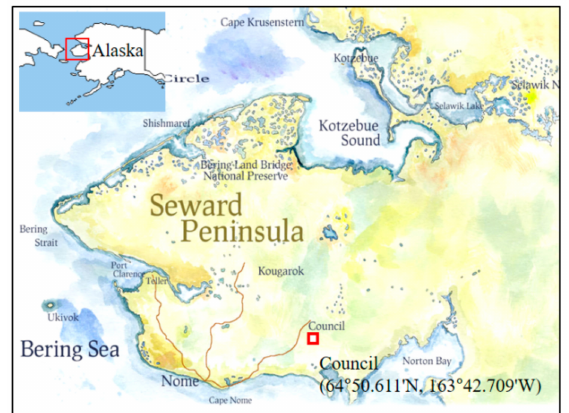
Figure 1. Measurement site in Council, the Seward Peninsula,